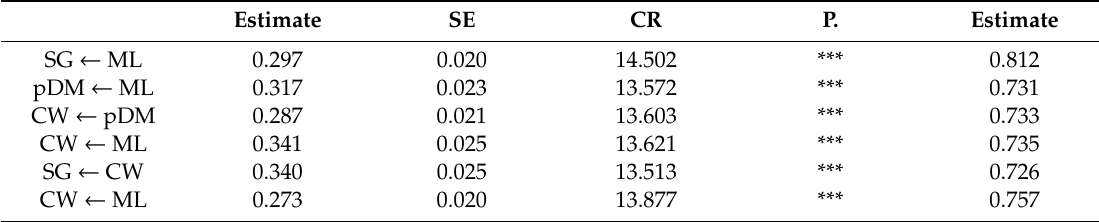
Table 2. Significant associations for the included variables.